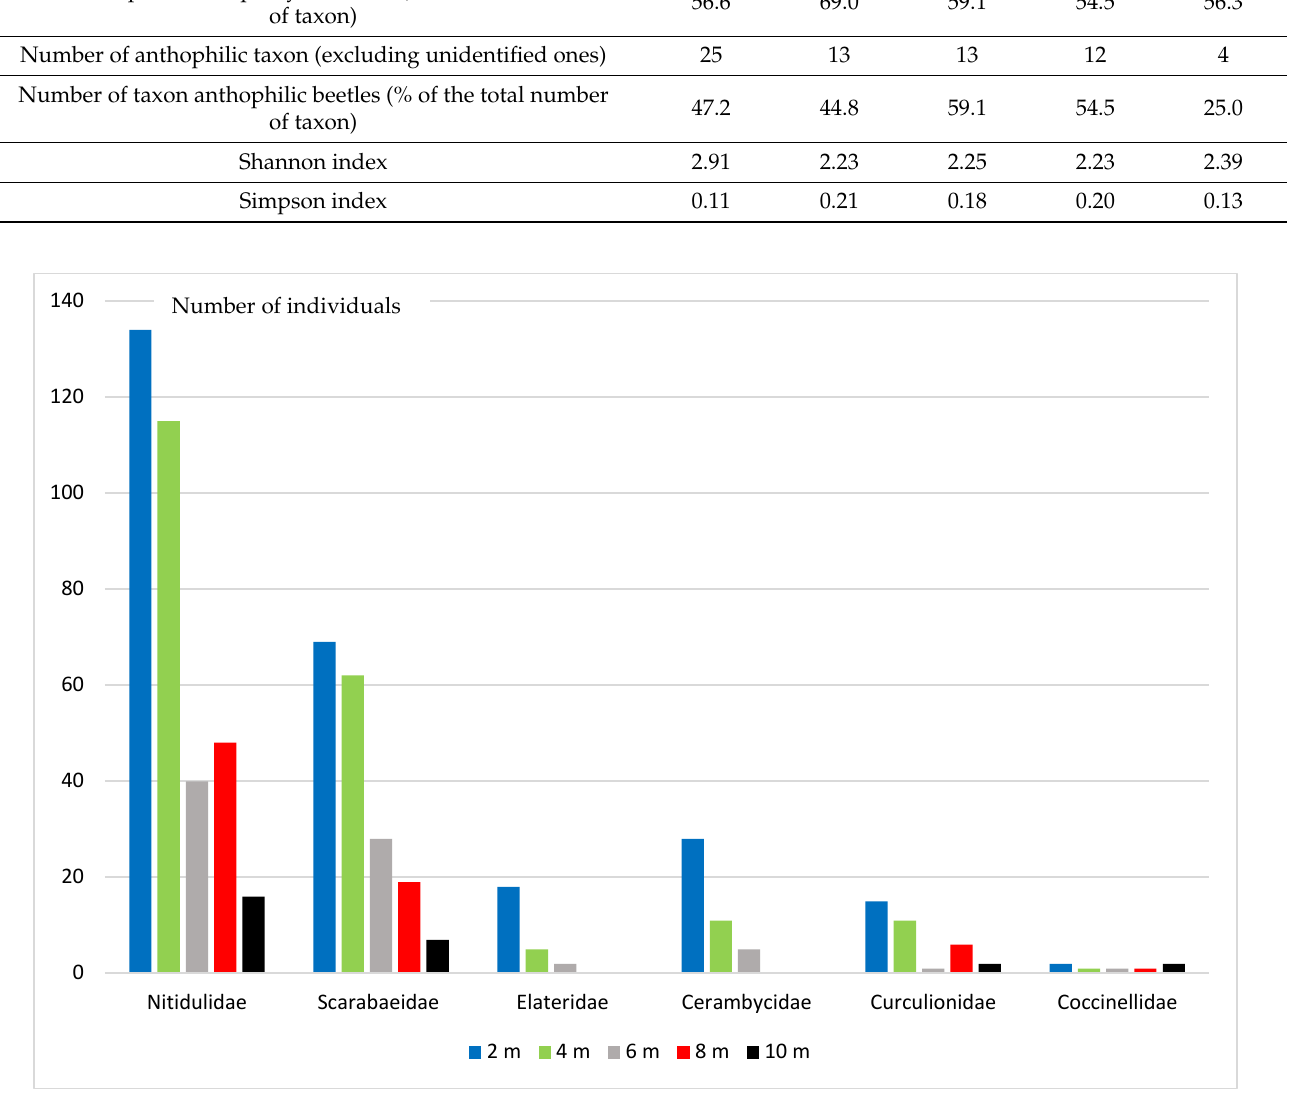
Figure 2. Numerical abundance of some Coleoptera families at different heights. Cryptarcha strigata (Fabricius, 1787) (total 228 specimens) and Protaetia marmorata (Fabricus, 1792) (113 specimens) had the largest numbers in beer traps. At all heights, only five species were observed in traps: P. marmorata , Malachius bipustulatus (Linnaeus, 1758), C. strigata , Cryptarcha undata (G.-A. Olivier, 1790), and Soronia grisea (Linnaeus, 1758). The largest abundance of P. marmorata was registered at heights from 2 to 6 m, with a maximum abundance at a height of 4 m. The abundance of C. strigata was greatest at a height of 4 m and slightly smaller at a height of 2 m. The highest abundance of S. grisea was registered at a height of 2 m. The data has not been obtained on the abundance of M. bipustulatus and C. undata at different heights. The calculation of the Jaccard similarity index demonstrated certain differences be- tween the Coleoptera species caught at different heights (Figure 3). The greatest differences were obtained between samples from a height of 2 and 10 m. The differences were mini- mal between the heights of 4 and 8 m.